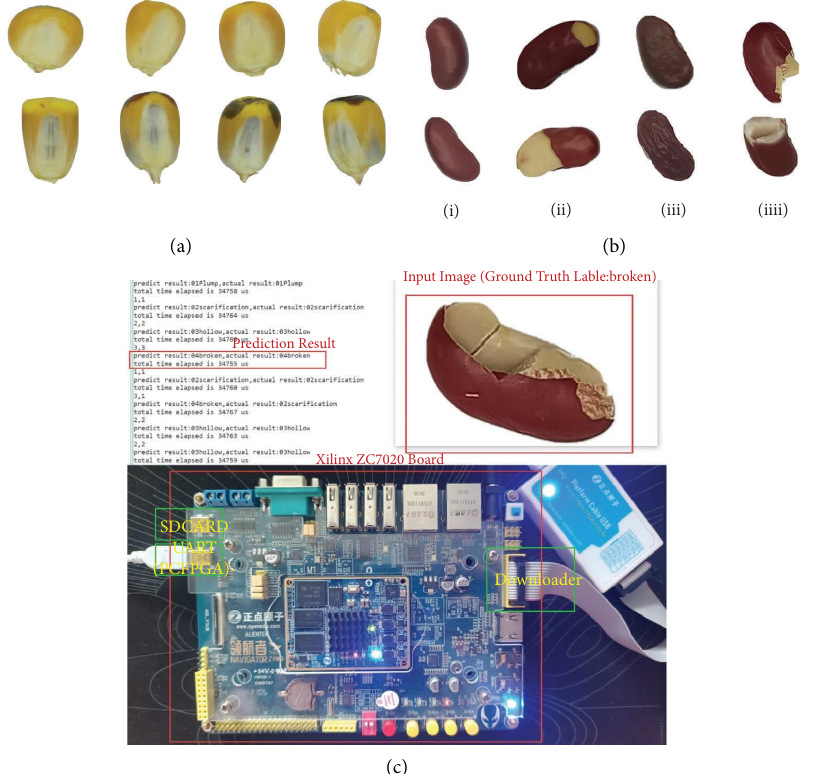
Figure 6: Experimental dataset and platform for seed sorting. (a) Maize seed dataset. (i) Haploid. (ii) Diploid. (b) Red kidney bean dataset. (i) Plump beans. (ii) Peeled beans. (iii) Dried beans. (iii) Broken beans. (c) Experimental platform for seed